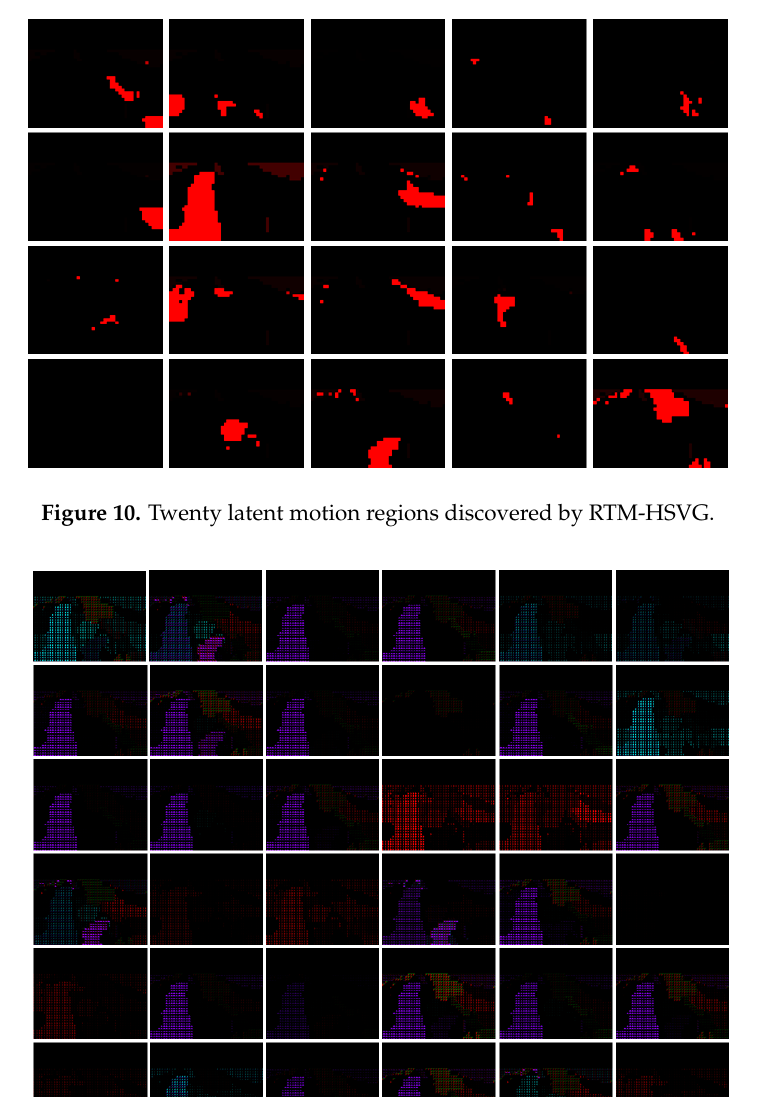
Figure 9. Eighteen latent motion topics discovered by RTM-GS.